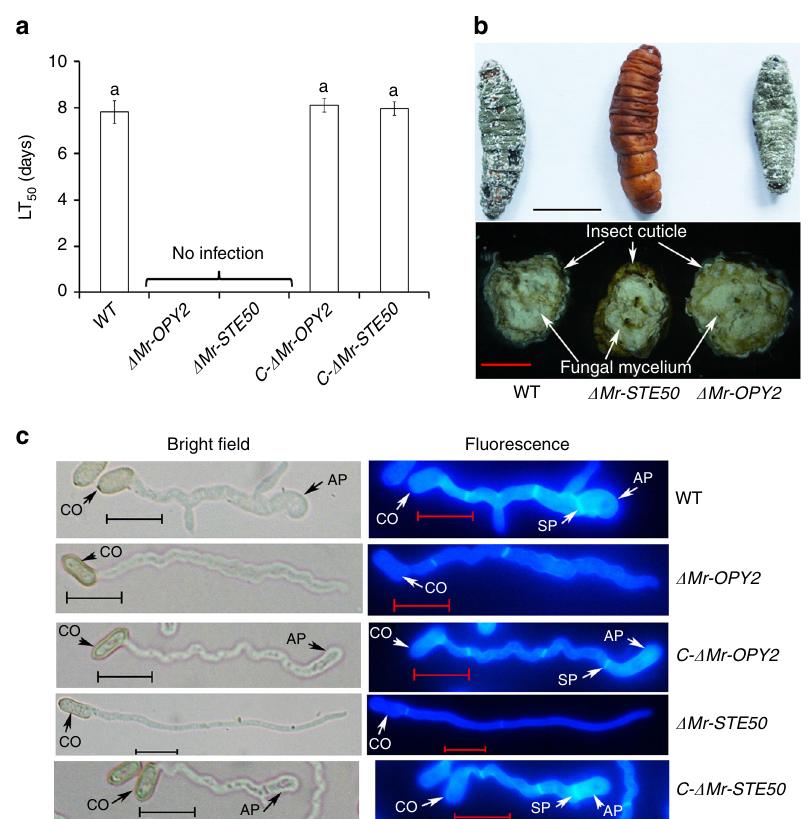
Fig. 1 Pathogenicity of WT, the mutants Δ Mr-OPY2 and Δ Mr-STE50 , and their respective complementation strains. a LT 50 (time taken to kill 50% of insects) values when the insects were inoculated by topical application. The bioassays were repeated three times with 40 insects per repeat. Data are expressed as the mean ± SE. Values with different letters are signi fi cantly different ( n = 3, P < 0.05, Tukey ’ s test in one-way ANOVA). b Upper panel: mycelial growth and conidiation on the surface of cadavers (scale bar represents 10 mm). Lower panel: mycelia in cross sections of cadavers (scale bar represents 5 mm). Each image is representative of ~ 120 insect cadavers (three replicates with 40 insects per replicate). c Formation of appressoria (stained with Calco fl uor Brightener White 2B) against a hydrophobic plastic surface. AP: appressorium; CO: conidium; SP: septum. Left: bright fi